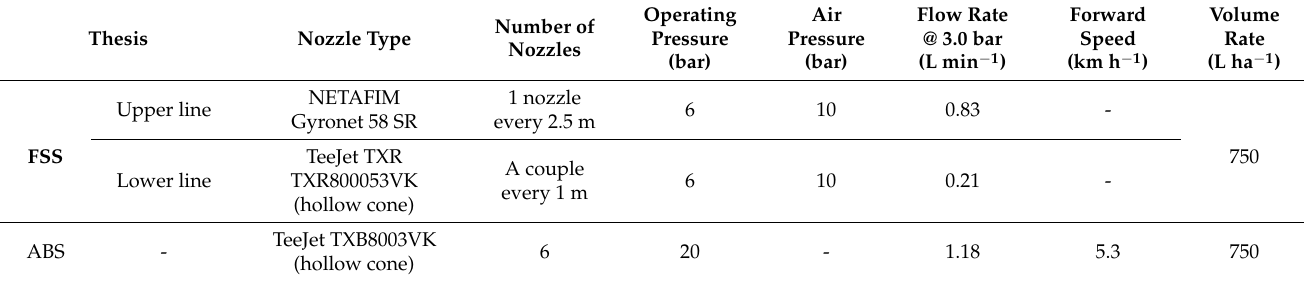
Table 4. Operating parameters used in every pesticide application in the Soave vineyard during